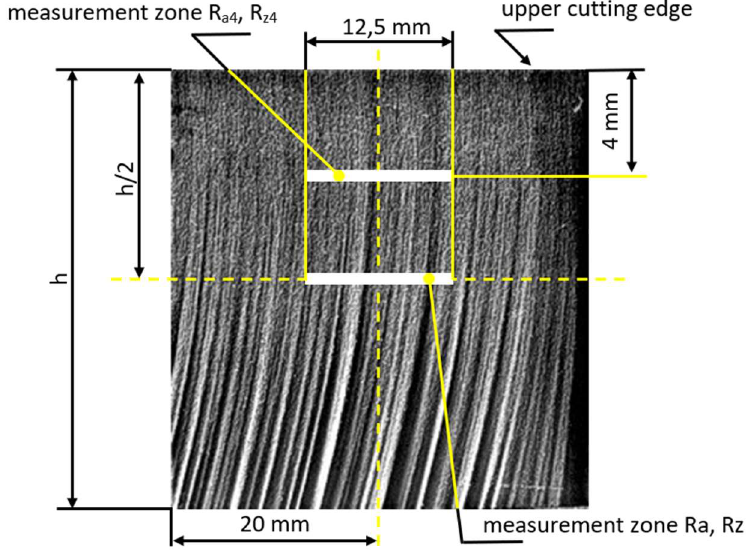
Figure 3. Roughness measuring zones for the parameters Ra , Rz , Ra 4 , and Rz 4 on the cut surfaces of the samples.